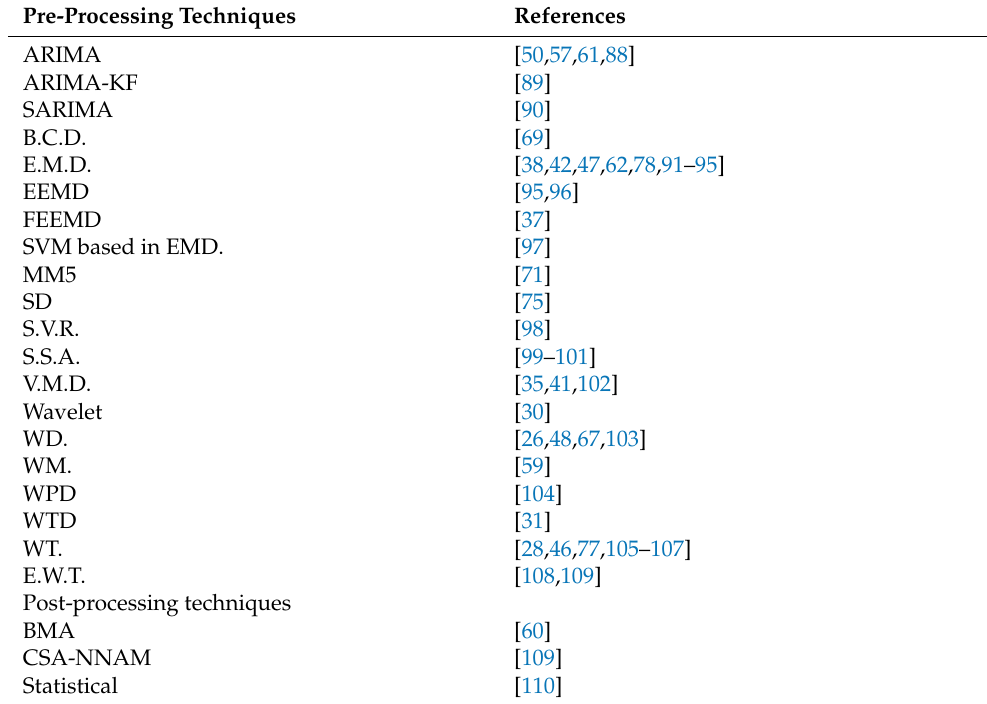
Table 2. Pre- and post-processing techniques used in the wind forecasting process. Pre-Processing